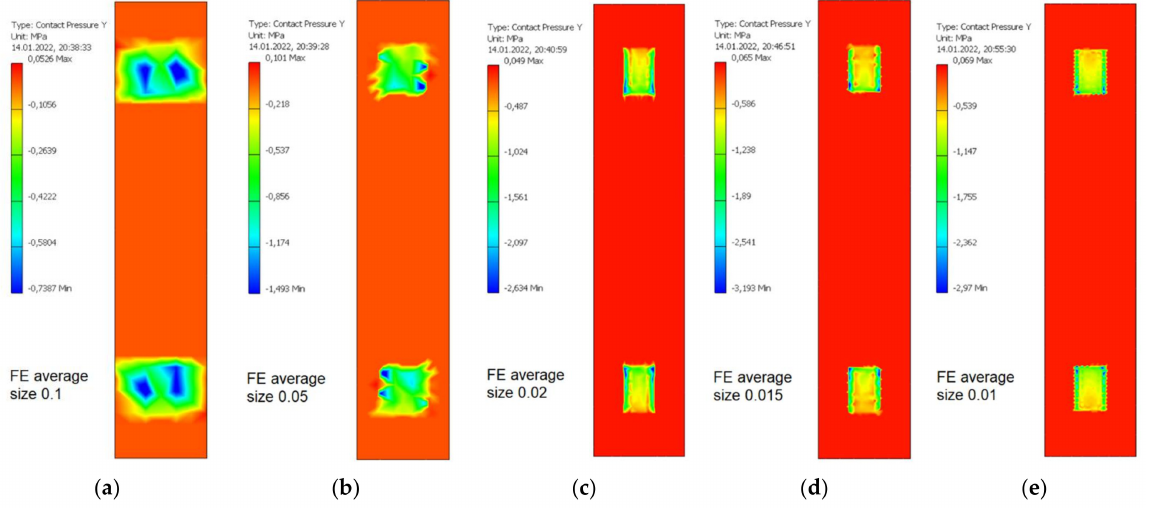
Figure 12. The values of normal contact pressure in the contact zone between eccentric and the segment of swivel arm for the various average finite element relative sizes. ( a ) 0.1; ( b ) 0.05; ( c ) 0.02; ( d ) 0.015; ( e )